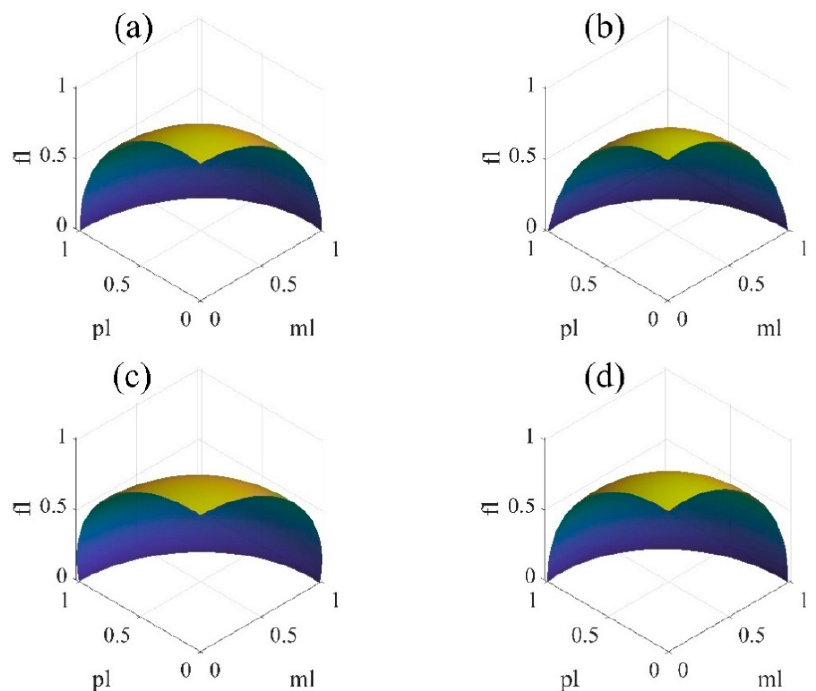
Figure 11. The limit state surfaces of straight pipes with local wall-thinning defects under the combination of internal pressure, bending moment, and axial force: ( a ) axial defect; ( b ) circumferential defect; ( c ) large-area defect; ( d ) small-area defect.